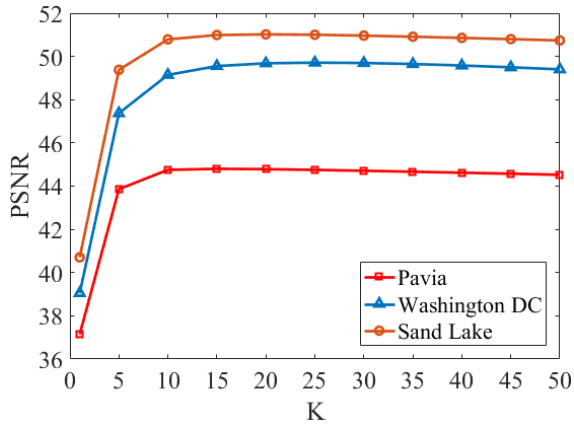
Figure 1. PSNR values for different K